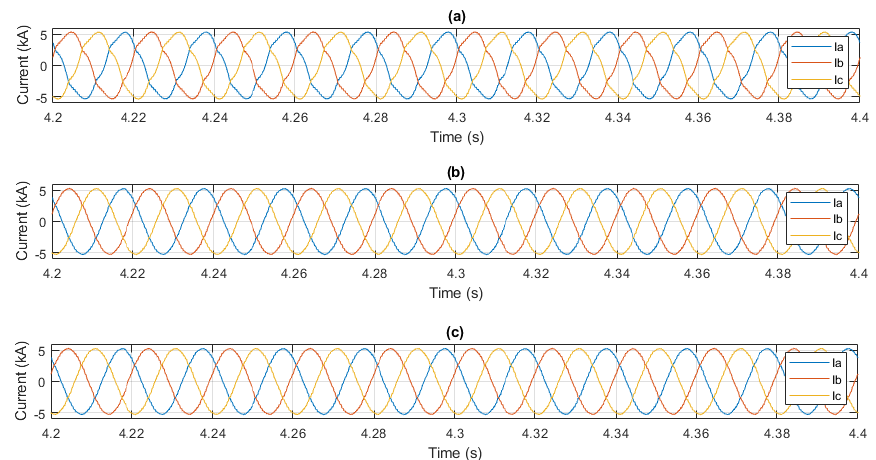
Figure 8. ( a ) Current at PCC—no harmonic compensation, ( b ) current at PCC—5th and 7th harmonics compensated. ( c ) Current at PCC—5th, 7th, 11th, and 13th harmonics compensated.